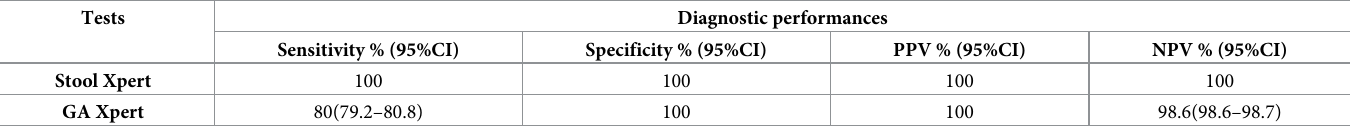
Table 4. The diagnostic performances of stool Xpert and GA Xpert using LJ culture and/or GA Xpert (microbiological confirmations) as one of the reference standards.